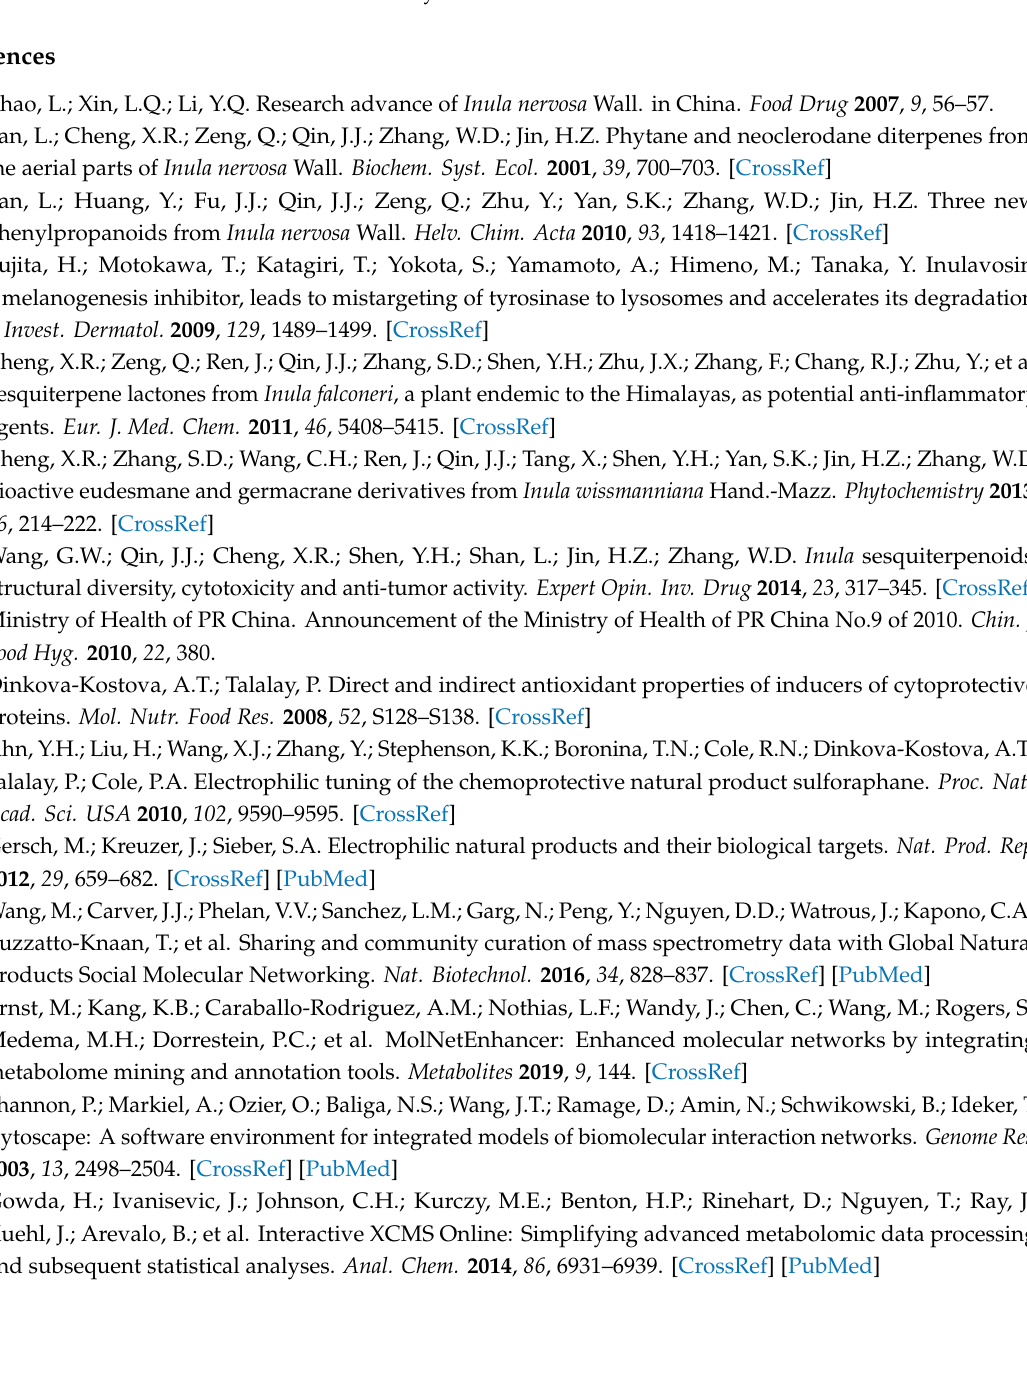
Supplementary Materials: The supporting information is available on the online version. Table S1. The unique features from the root IE, Table S2. The unique features from the stem IE, Table S3. The unique features from the leaf IE, Table S4. The unique features from the flower IE, Table S5. The analog hits against GNPS library, Table S6. List of di ff erential secondary metabolites from root, stem, leaf, and flower IEs, Table S7. List of di ff erential secondary metabolites from root and stem IEs, Table S8. List of di ff erential secondary metabolites from root and leaf IEs, Table S9. List of di ff erential secondary metabolites from root and flower